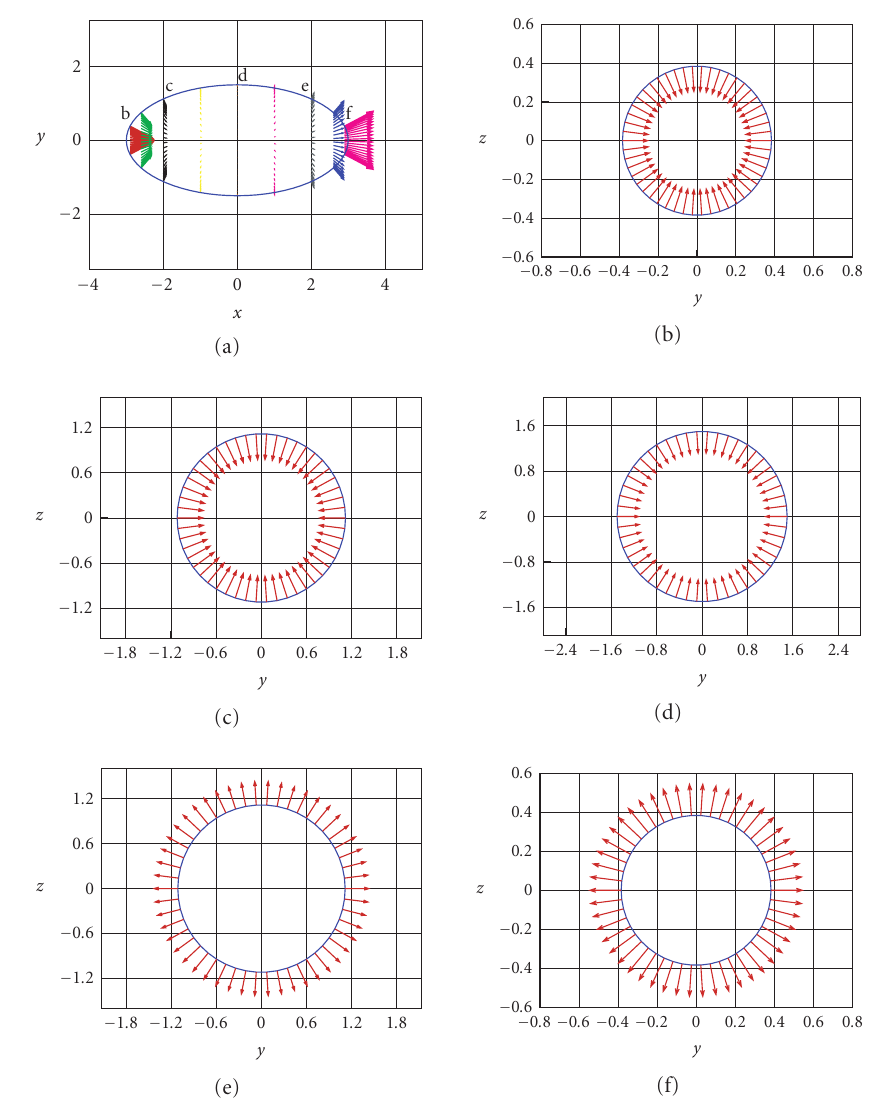
Figure 6.12. Distribution of the normal stress T nn on various cross sections on the ( y , z )-planes of an ellipsoid (with semiaxes a = 3, b = 1 . 5, c = 1 . 5 cm) immerse in a flow of fluid M1 with a Reynolds number of 0 . 05. (a) ( T nn n x + T nn n y ) / 100dyn/cm 2 for an ellipsoid x 2 /a 2 + y 2 /b 2 = 1 − z 2 /c 2 with z = 0, in the ( x , y )-plane. (b) ( T nn n y + T nn n z ) / 250dyn/cm 2 for an ellipsoid y 2 /b 2 + z 2 /c 2 = 1 − x 2 /a 2 with x = − 2 . 9 cm, in the ( y , z )-plane. (c) ( T nn n y + T nn n z ) / 50dyn/cm 2 for an ellipsoid y 2 /b 2 + z 2 /c 2 = 1 − x 2 /a 2 with x = − 2 . 0 cm, in the ( y , z )-plane. (d) ( T nn n y + T nn n z )dyn/cm 2 for an ellipsoid y 2 /b 2 + z 2 /c 2 = 1 − x 2 /a 2 with x = 0 . 0cm, in the ( y , z )-plane. (e) ( T nn n y + T nn n z ) / 50dyn/cm 2 for an ellipsoid y 2 /b 2 + z 2 /c 2 = 1 − x 2 /a 2 with x = 2 . 0cm, in the ( y , z )-plane. (f) ( T y 2 /b 2 + z 2 /c 2 = 1 − x 2 /a 2 with x = 2 . 9 cm, in the ( y , z